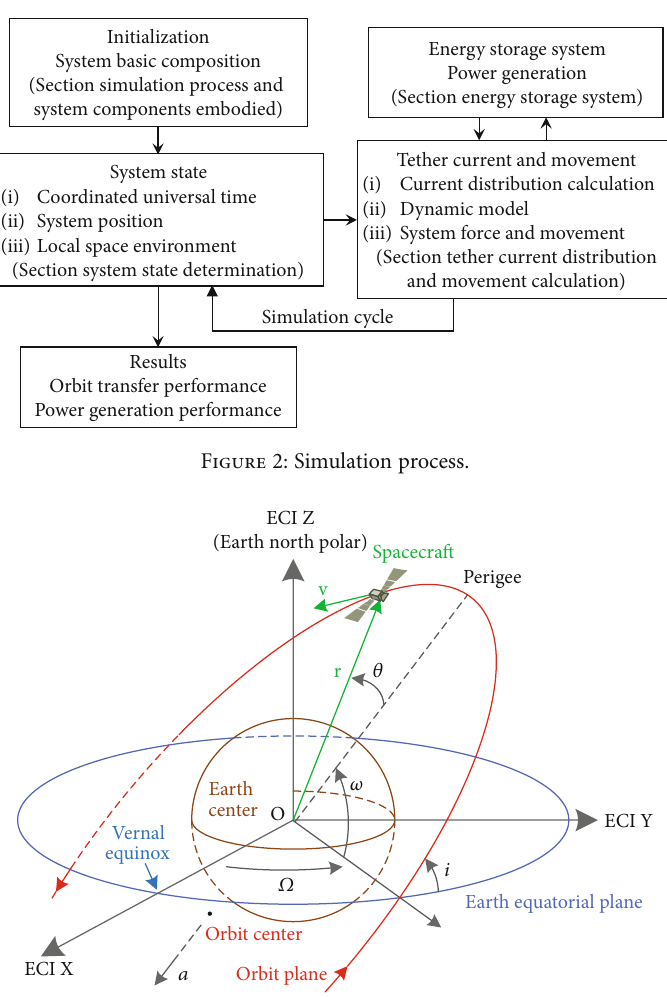
Figure 3: ECI coordinate system and classical orbital